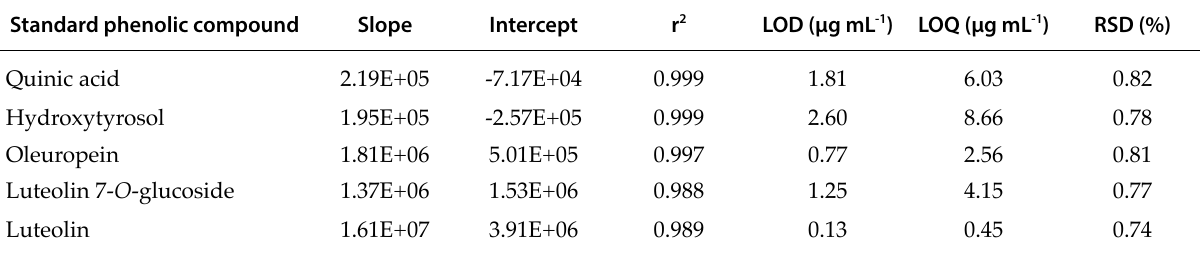
Table 3. Parameters of calibration curves, limit of detection (LOD), limit of quantification (LOQ) and relative standard deviation (RSD) for the HPLC method validation of phenolic assays.